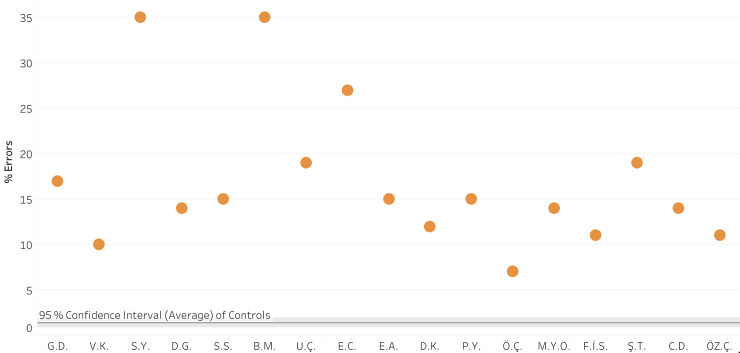
Reading words: %vowel errors (of the 124 words) for each vowel dyslexia participant (orange dots) compared to the control group (average in the horizontal line, with 95% confidence interval around it).